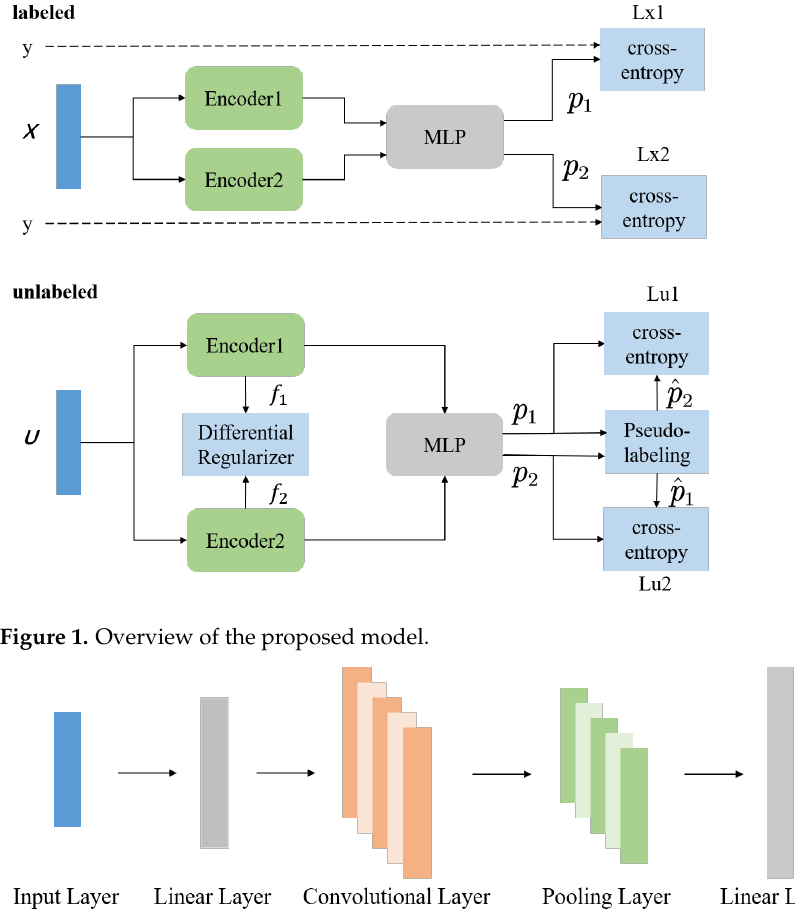
Figure 2. An illustration of the composition of the encoder. The encoder mainly consists of a connection layer, a convolutional layer, a pooling layer, and a connection layer. The main alteration part of different encoders is in the pooling